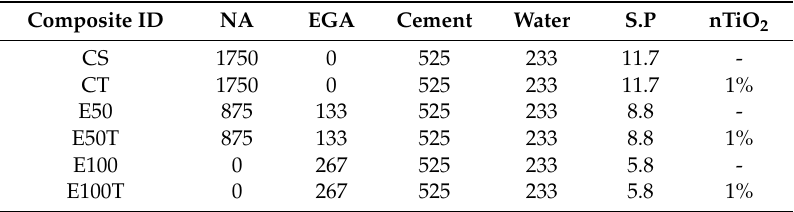
Table 3. Mix proportion of the samples (kg / m 3 ) of